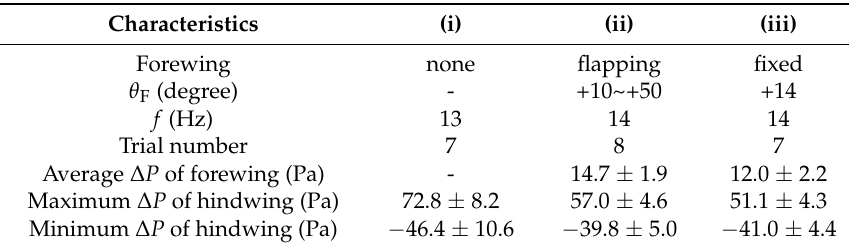
Table 3. Performances of the ornithopter during flight ( i ) without a forewing ( ii ) with a flapping forewing and ( iii ) with a fixed